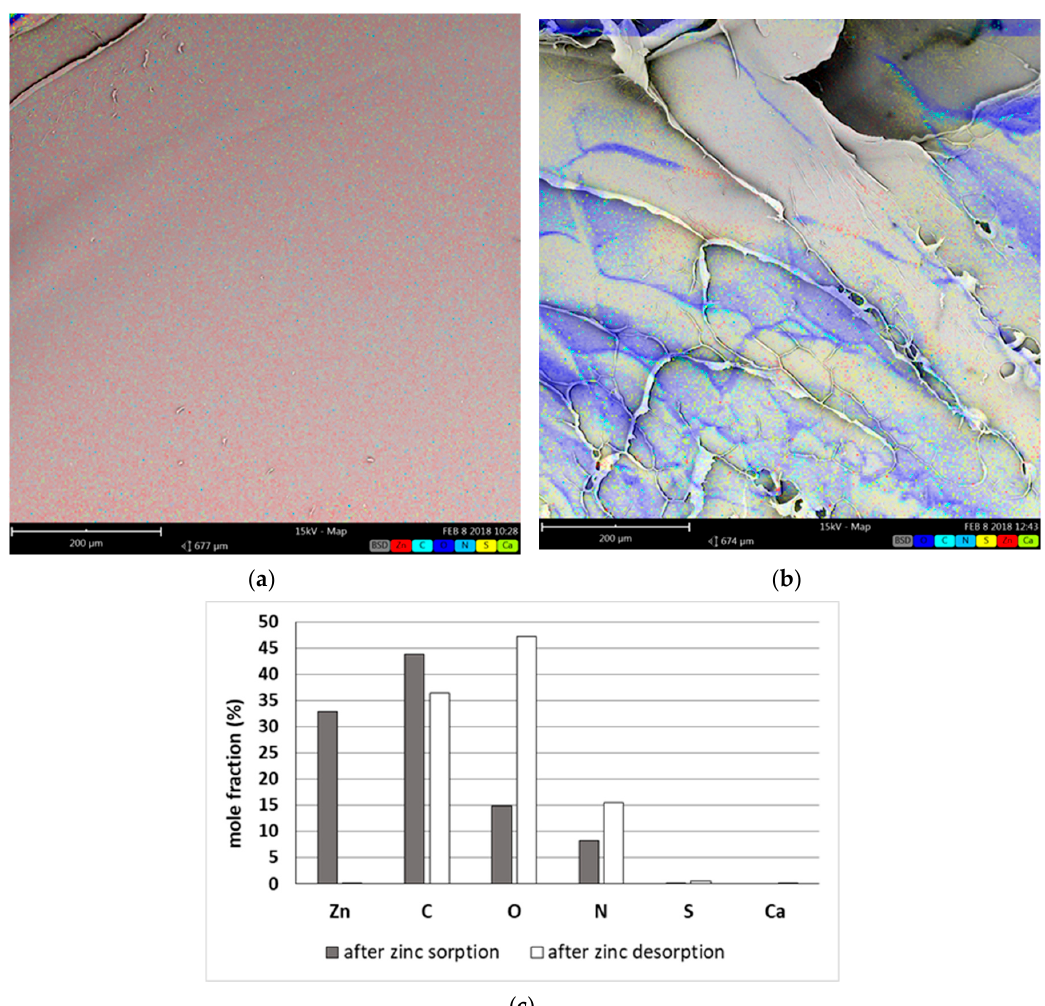
Figure 7. The results of the SEM with energy-dispersive X-ray spectroscopy (EDS) analysis of the biosorbent grain cross-section: ( a ) after zinc sorption (FOV: 677 μ m, Mode: 15 kV—Map, Detector: BSD Full); ( b ) after zinc desorption (FOV: 674 μ m, Mode: 15 kV—Map, Detector: BSD Full); and ( c ) numerical values of data presented in the pictures (a,b).